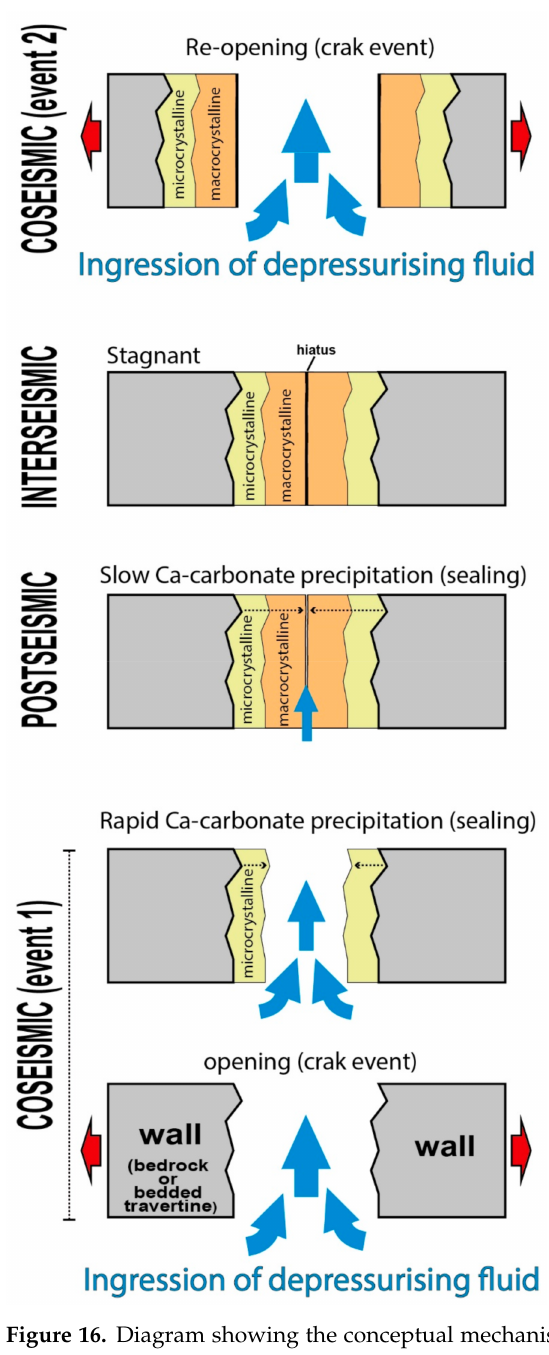
Figure 16. Diagram showing the conceptual mechanism forming the banded Ca-carbonate veins during a seismic cycle. See the text for more